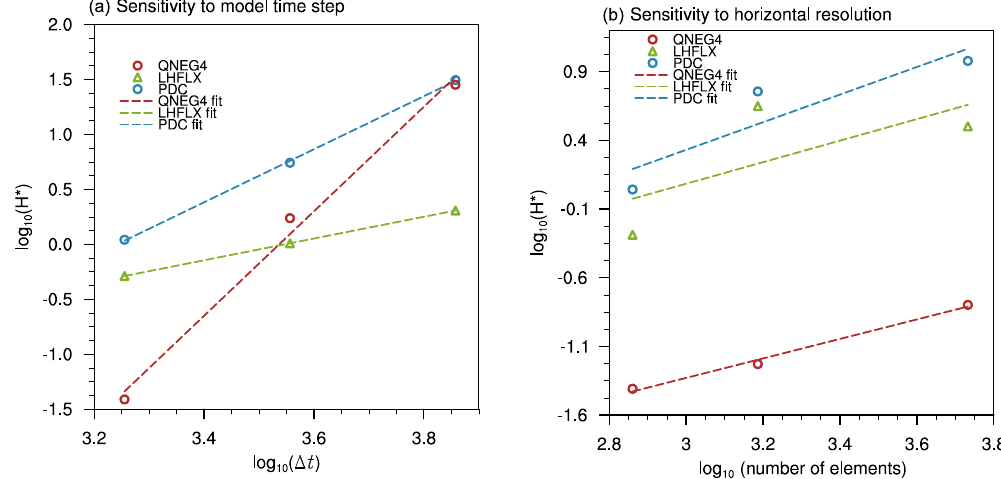
Figure 4. Sensitivity of water conservation error to (a) temporal resolution and (b) horizonal resolution in the V1 α model. The y axes in both panels show the global mean sea level change estimated from 5-day simulations using Eq. (6). The unit of (cid:49)t for the x axis in (a) is seconds. The upper panel shows results conducted at 2.8 ◦ (ne11) resolution with different time step sizes. The lower panel shows results using the same time resolution but at 2.8 ◦ (ne11), 1.9 ◦ (n16), and 1 ◦ (ne30) resolutions. Details of the simulation configurations are explained in Sect. 5.2.1 and 5.2.2. Only the three largest error sources are plotted in each